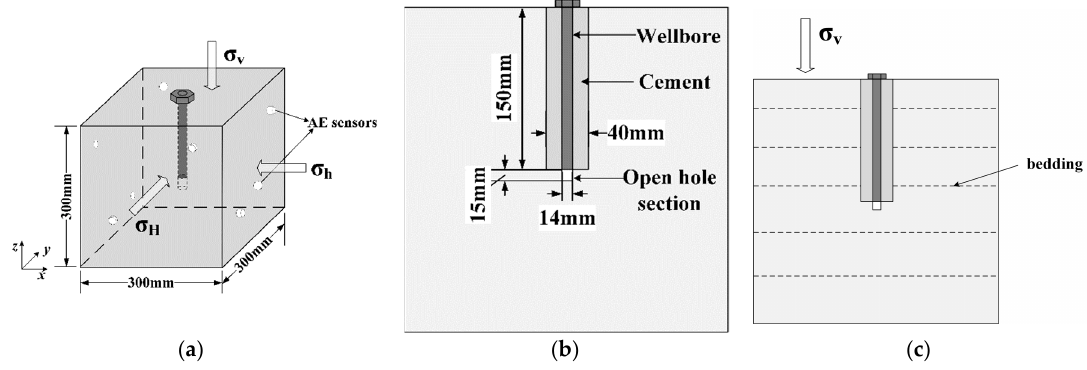
Figure 2. ( a ) AE sensor layout and loading schematic diagram; ( b ) sectional view of specimen schematic diagram; ( c ) the orientation of beddings in shale schematic diagram.